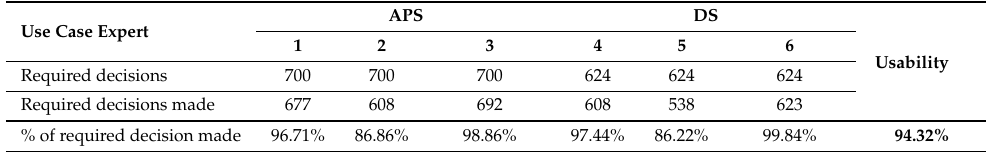
Table 6. Calculation of the usability